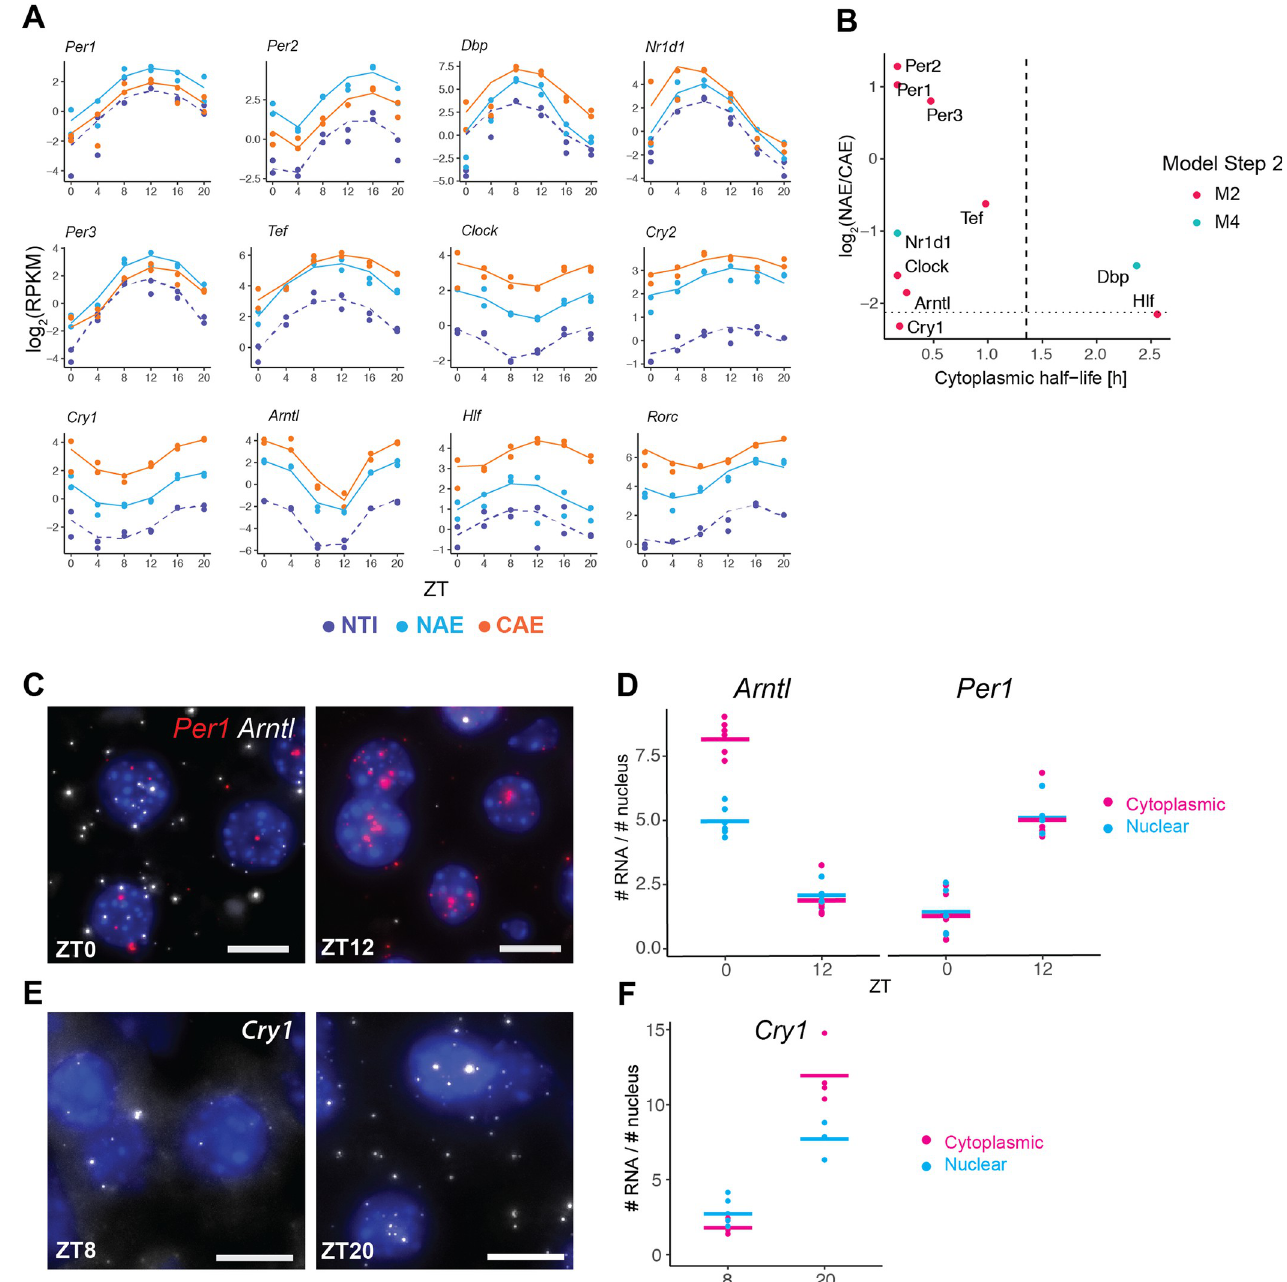
Fig 6. Circadian core clock and PARbZip genes. A : RNA-seq temporal profiles of clock genes and clock-controlled genes (PARbZip family members), sorted by their nuclear-to-cytoplasmic ratio. B: log 2 (NAE/CAE) versus cytoplasmic half-life estimated at step 2. Dashed vertical line represents the median half-life times of all rhythmic mRNAs. Dotted horizontal line represents the median log 2 (NAE/CAE) ratio of all rhythmic mRNAs. C and E: smFISH of core clock mRNAs Per1 , Arntl , and Cry1 at their maximal and minimal expression levels in mouse liver tissue. Nuclei stained with DAPI (blue). Scale bar: 10 μ m. 63x magnification. D and F: Quantification of nuclear and cytoplasmic mRNA transcripts on smFISH images. The nuclear-to-cytoplasmic ratio of Per1 is significantly more nuclear than Arntl and Cry1 at their respective peak time (pairwise t-test, Bonferroni correction, p-value < 10 − 5 ) and < 10 − 4 respectively). 4–6 images were taken per animal, with each field of view containing on average 500 nuclei. The average number of mRNA molecules per number of nuclei in each image is represented (dots). Number of nuclei analysed: Arntl and Per1 : 3237 (ZT0), 3300 (ZT12). Cry1 : 1714 (ZT8) and 1319 (ZT20).